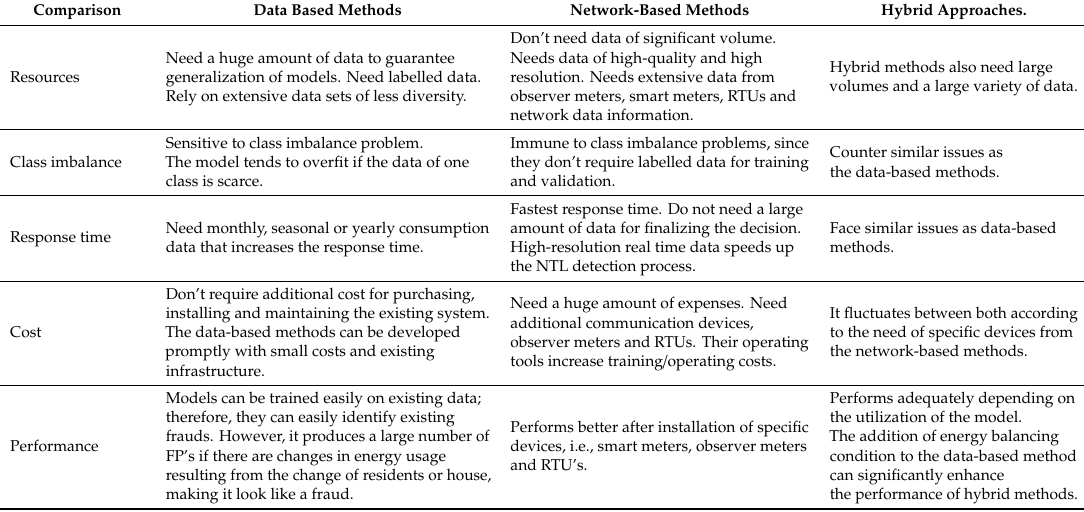
Table 5. Comparison among data based, network based and hybrid-based methods for NTL detection. Comparison Data Based Methods Network-Based Methods Hybrid